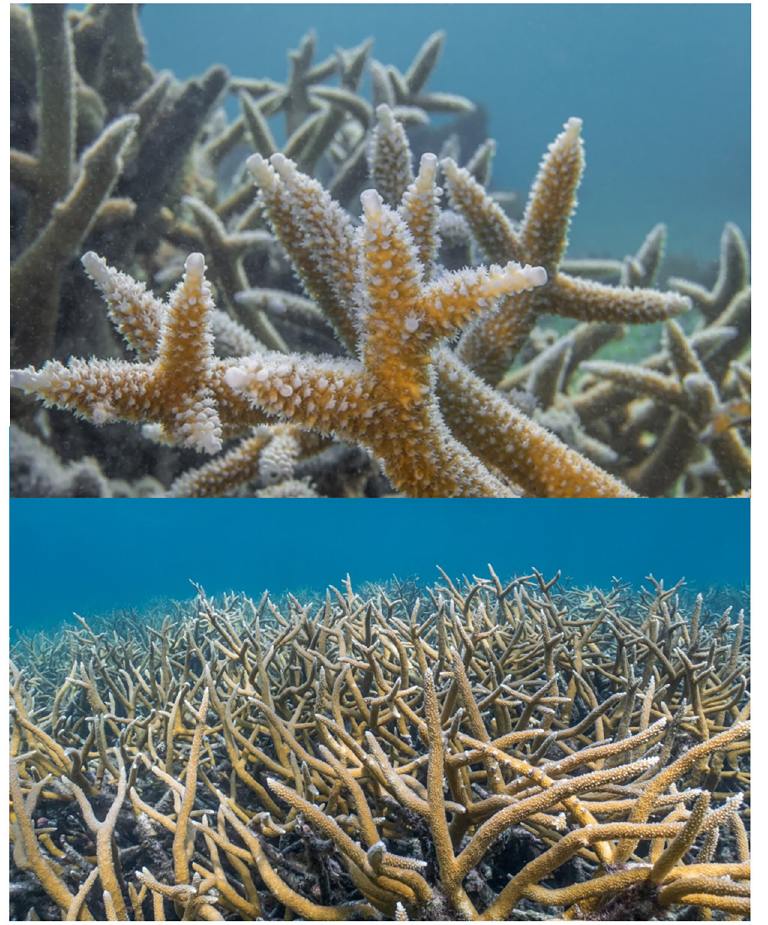
Fig 7. Healthy Acropora cervicornis at Transect 5 in June